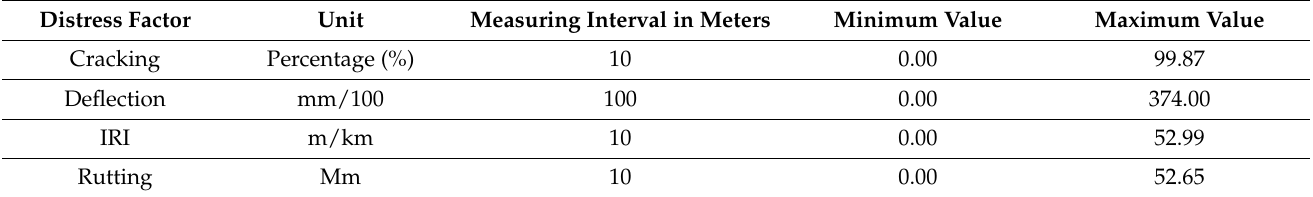
Table 1. Details of distress parameters.